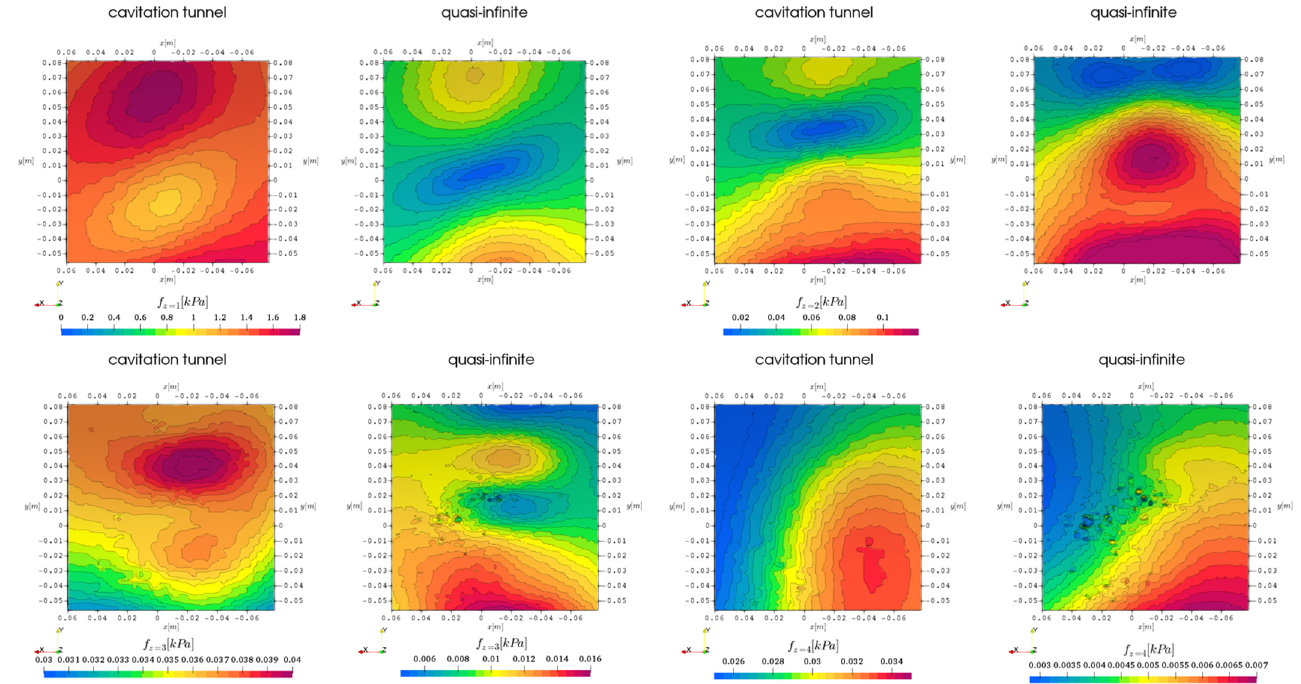
Figure 4. First 4 harmonic propeller blade frequencies incompressible hull pressure above propeller, comparison of domain extent, RANS with cavitation.